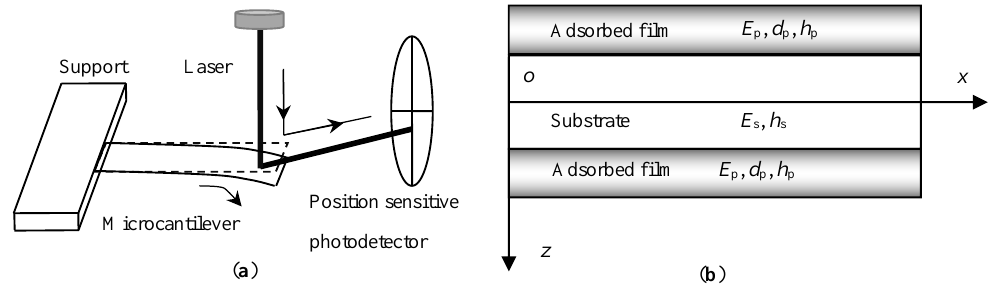
Figure 1. ( a ) Scheme of the Atomic Force Microscope (AFM) measurement; ( b ) schematic showing a microbeam and its coordinate system.